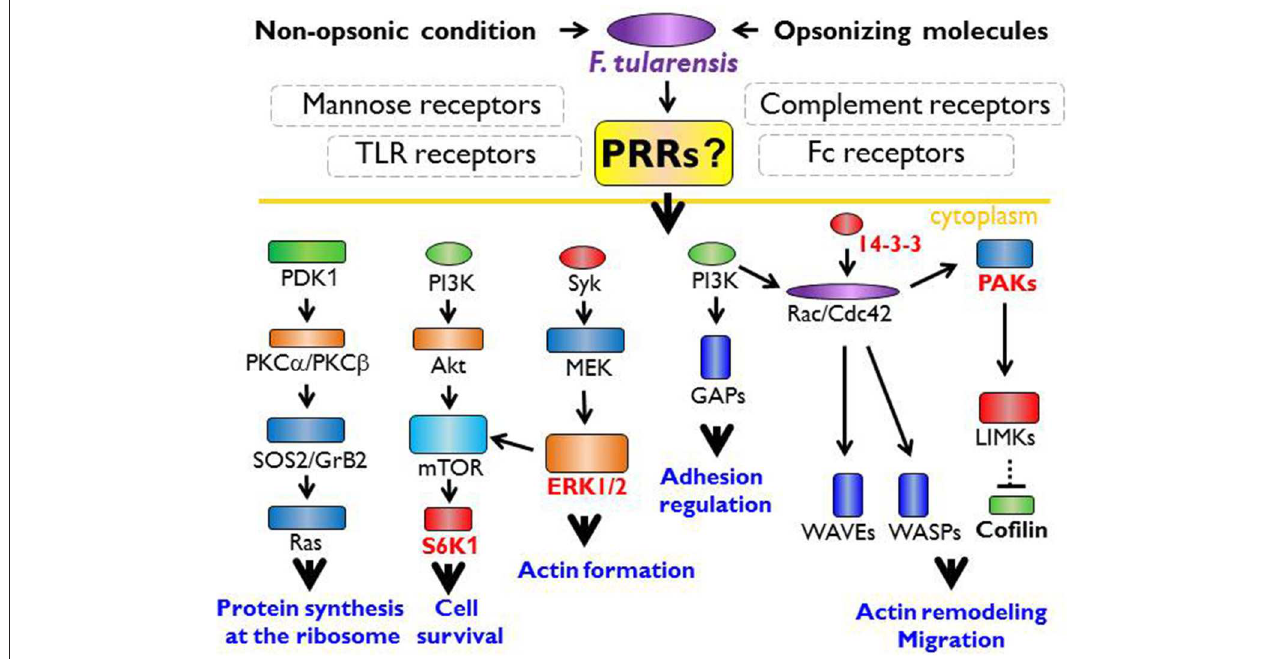
FIGURE 1 | The innate immune receptor engagement and possible signaling pathways in actin cytoskeleton remodeling. Within the common paradigm of innate immune recognition, there is no doubt the first signal for recognition of Francisella spp. must originate from the cell surface receptors. Francisella is recognized via TLR (Toll like receptor) heterodimers, especially TLR1 or 6, TLR2, and TLR4 that lead to myddosome formation followed by activation of NF κ B (nuclear factor kappa-light-chain-enhancer of activated B cells), p38 protein and the activation of inflammatory cytokine genes. The signaling through TLR2 and TLR4 is possible only from the phagosome. Thus, TLR-MyD88 (myeloid differentiation primary response 88) complex is moved to the lipid rafts followed by the endocytosis. Nevertheless, there should be other signal from unknown receptor that ensures the moving of TLR-MyD88 complex into the phagosome by activation of actin cytoskeleton remodeling processes. From published data, the signaling pathways via S6K1 (ribosomal protein S6 kinase beta-1), ERK1/2 (extracellular signal-regulated kinase 1), 14-3-3 protein, or PAKs (p21-activated kinases) seem to be important for the actin remodeling, the actin cytoskeleton activation, and the regulation of transcription/translation needed for signal transduction and functional